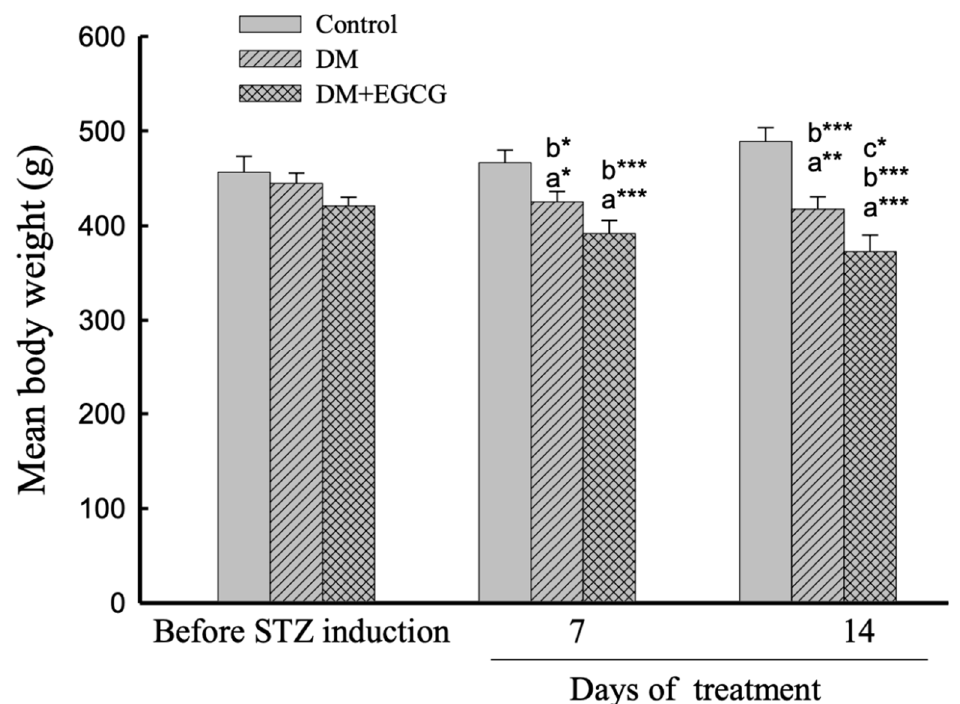
Figure 1. Body weight changes. The data were expressed as mean ± SEM. *, p < 0.05; **, p < 0.01; ***, p < 0.001. (a), compared to the control group at the same time point (7 days or 14 days); (b), compared to the same group before STZ injection; (c), compared to the DM group at the same time point. DM, diabetes mellitus; EGCG , epigallocatechin gallate; STZ, streptozotocin.